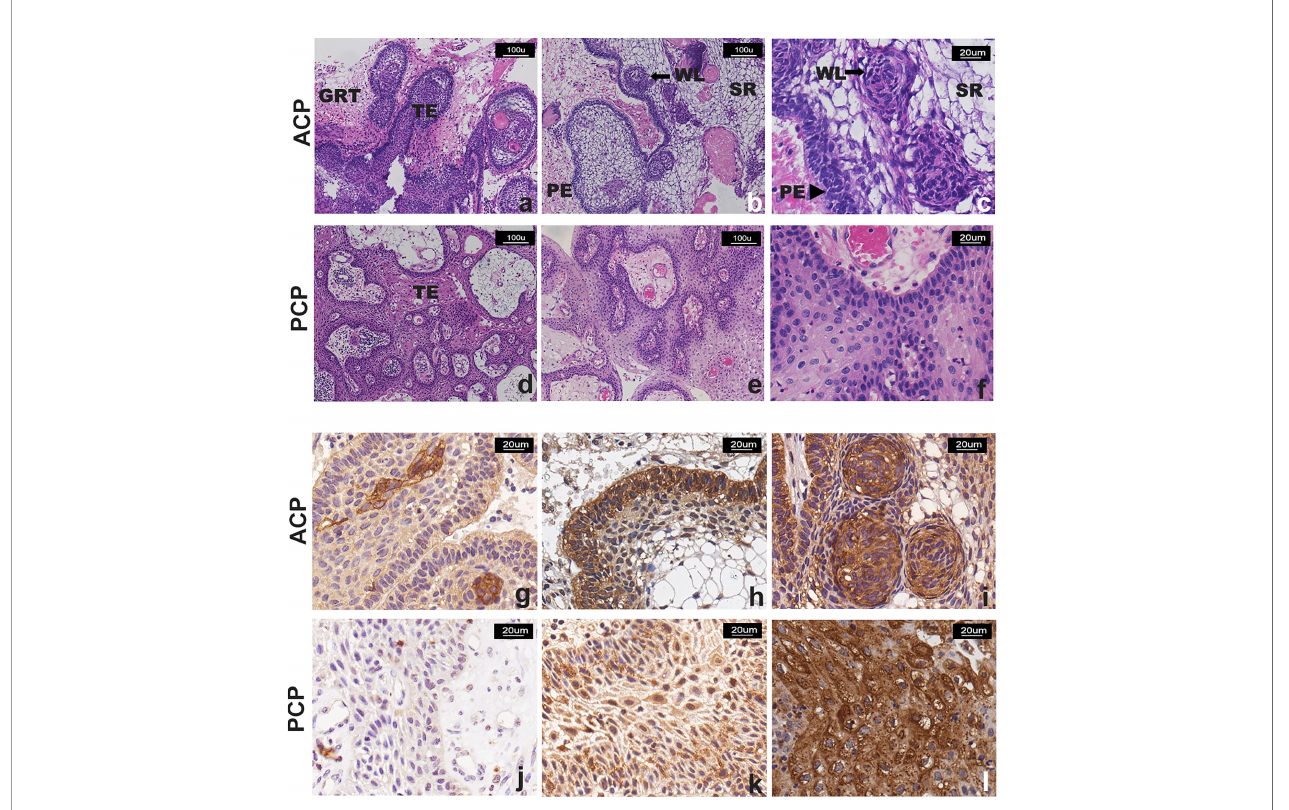
FIGURE 2 | Representative images of H&E staining and TrkA immunostaining of CP patients. (A – F) H&E staining: (A – C) two cases of ACP, showing “ fi nger-like ” and “ island-like ” aggressive growth structures; (D – F) two cases of PCP, showing that the tumor was composed of non-keratinizing squamous epithelium, with visible blood vessels in the interstitial, without invasive growth structure. TE, tumor epithelium; GRT, glial reactive tissue; PE, palisading epithelium; WE, “ whorled epithelium ” cell groups; SR, stellate reticulum. (G – L) TrkA immunostaining, the signal intensity was moderate and strong and more manifested in the tumor cells that form the “ whorled epithelium ” structure (G, I) and the palisade epithelium (H) in ACP; the signal was observed in (J) <10% and (K) >50% with moderate and strong intensity or (L) strong and diffuse (51% – 80% of neoplastic cells) immunoreactivity in PCP. Panels (A, B, D – F) were captured at 100×, and others were captured at 200× magni fi